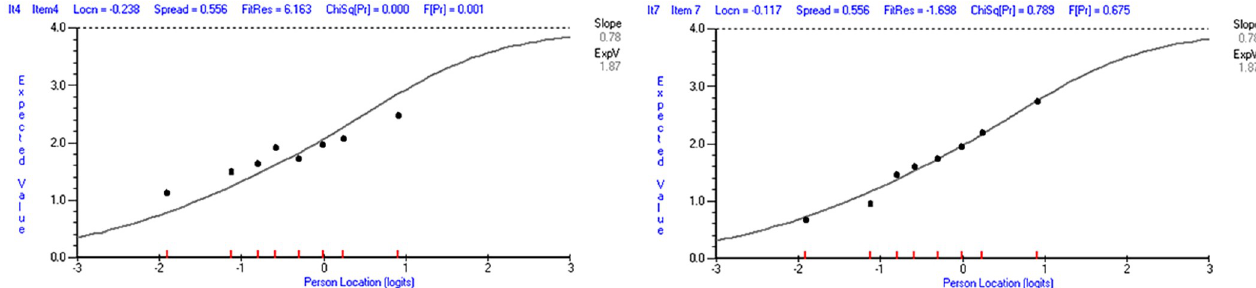
Fig 4. Item characteristic curve for Item 4 (left) and Item 7 (right). Note. The x-axis indicates the latent trait and the y-axis indicates the item score. The black points represent the average observed item responses in each class interval. The grey logistic curve indicates the expected item responses. The slope of the Item Characteristic Curve indicates the rate of change of the expected value with respect to the latent trait at the mid-point between the minimum and maximum scores.